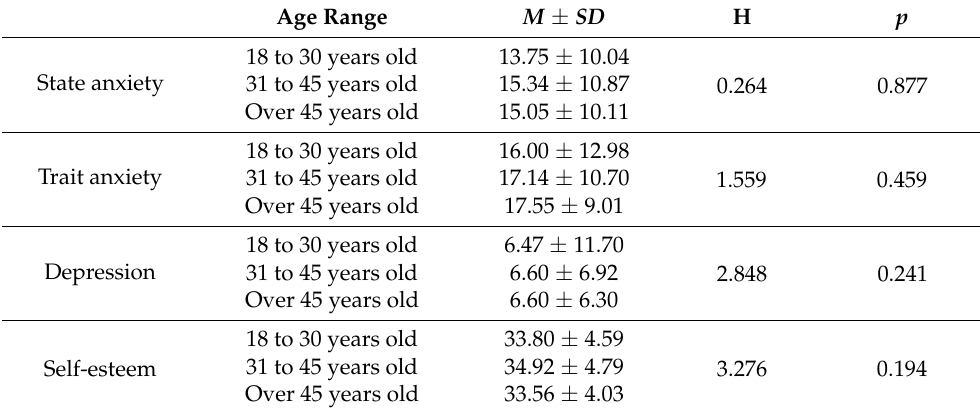
Table 6. Results for the differences in the speleologists sample according to age.